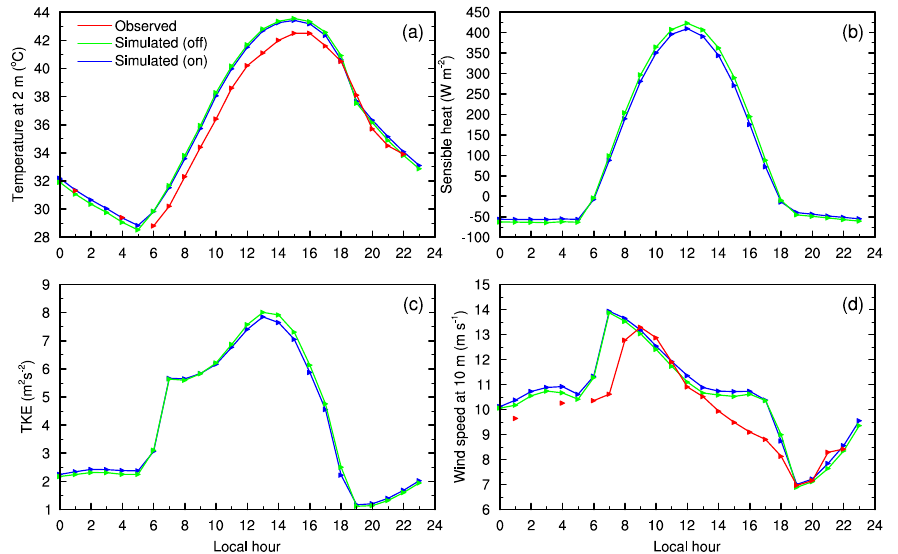
Fig. 2. The observed (red) and simulated (for radiative forcing on (blue) and off (green)) monthly averaged diurnal variation of (a) air temperature at 2m ( ◦ C), (b) surface sensible heat flux (Wm − 2 ), (c) turbulent kinetic energy (m 2 s − 2 ) in the first model layer and (d) wind speed at 10m (ms − 1 ) over Zabol during July